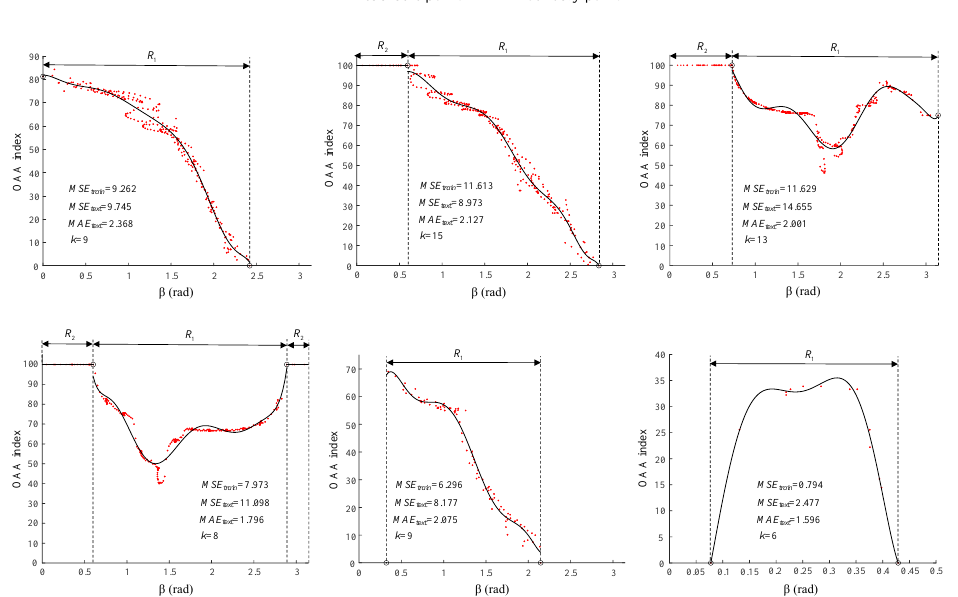
Figure 15. The OAA index prediction model of each reachability sphere at the top of Figure 14 is given, where MSE train and MSE text represent the mean-squared error of the sample points in R 1 of the training set and the testing set for the polynomial model, MAE text represents the mean absolute error of all the testing points in the reachability sphere for the whole prediction model, and k represents the polynomial degree.